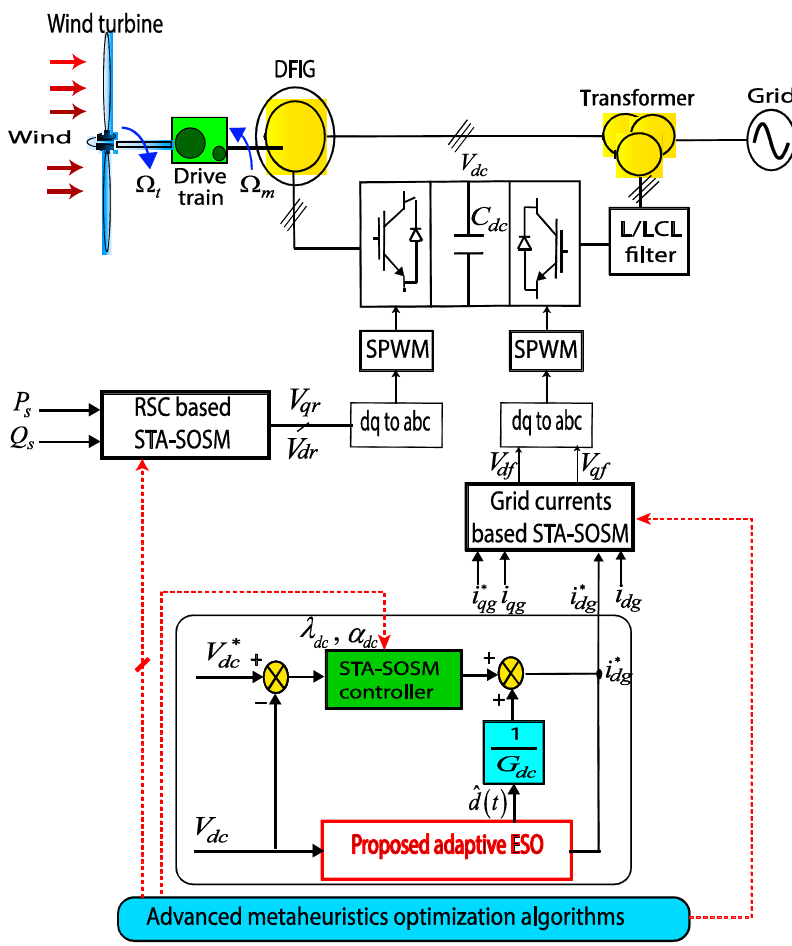
Figure 1. General block diagram for the proposed control scheme method.